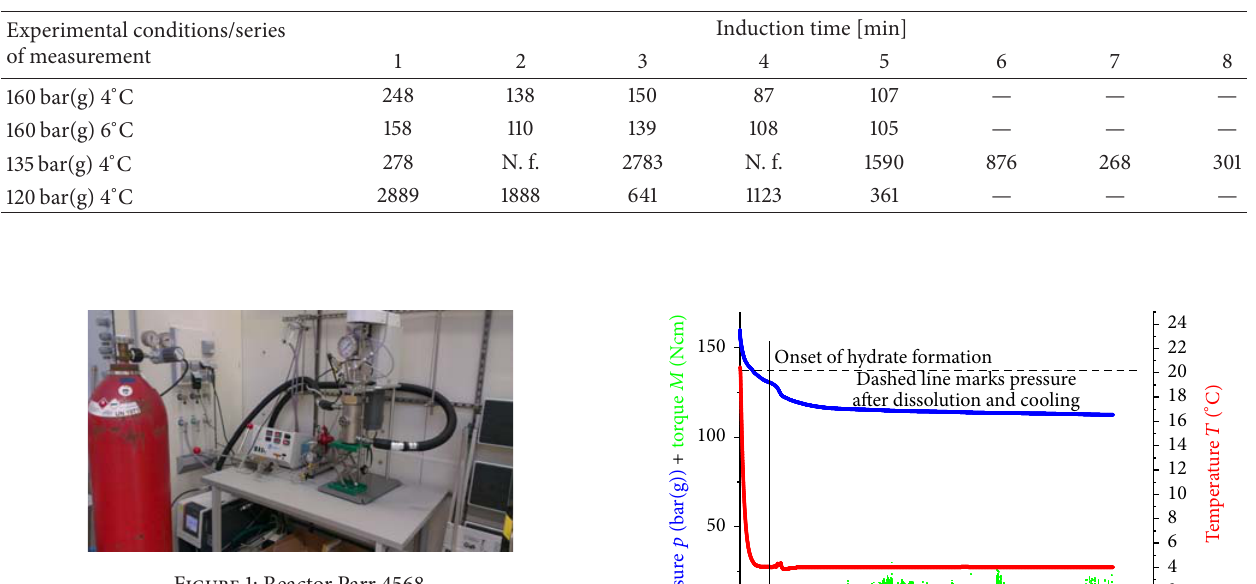
Table 3: Induction times of four exemplary series of measurements.